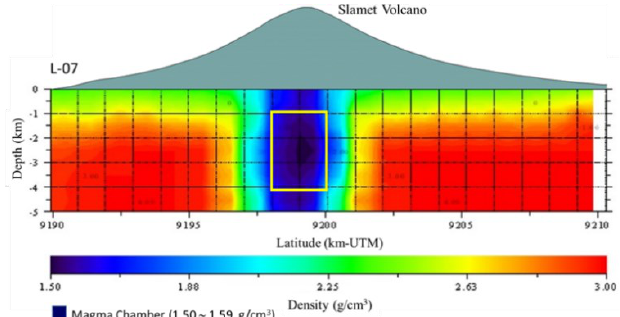
Fig. 16. A cross-section of the anomalous object model along L-07 trajectory at longitude of 303.530 km-UTM